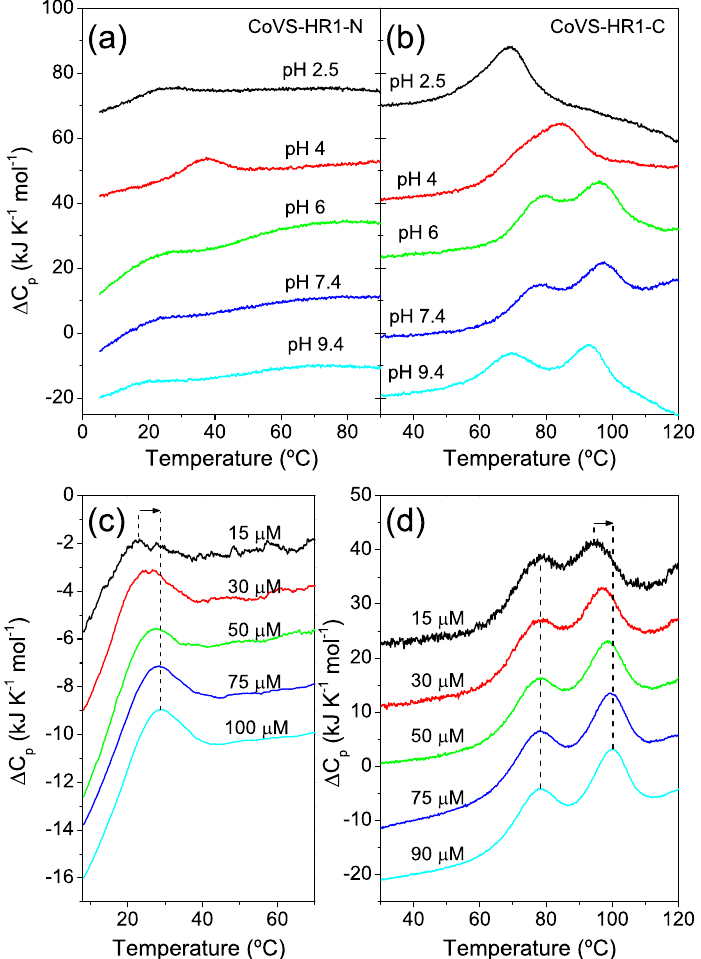
Figure 8. Thermal unfolding of shortened CoVS-HR1 miniproteins. ( a , b ) DSC scans of CoVS-HR1- N ( a ) and CoVS-HR1-C ( b ) measured at varying pH values as indicated next to each curve. The protein concentration was 30 μ M in all experiments. ( c , d ) Effect of protein concentration on the DSC thermograms at pH 7.4. Al experiments were recorded at a scan sate of 90 °C h − 1 . The thermograms are artificially displaced along the vertical axis for the sake of clarity.